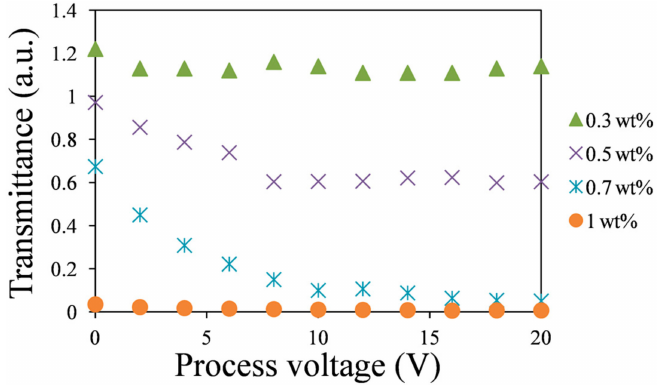
Figure 9. Multistable T–V curves of HFW59200-200 cells doped with various gelator concentrations. The transmittance was measured without an applied